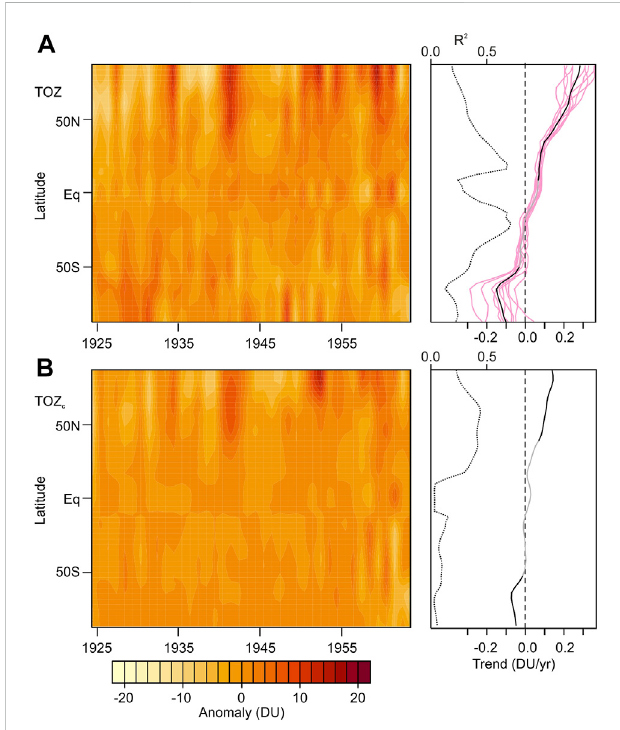
Residuals of the regression for TOZ (A) and TOZ c . (B) Right: linear trends per latitude for the corresponding datasets over the 1924 – 1963period(non-signi fi cant( p =0.05)ingrey, signi fi cantinblack, andindividualmembersforTOZinpink).Thedottedlineintheright panels shows the explained variance of the regression model.